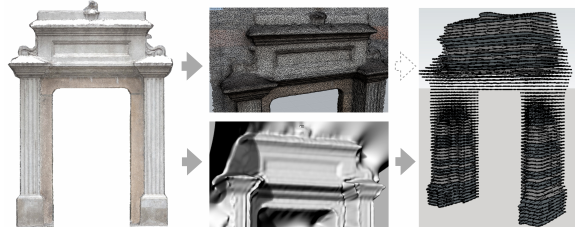
Figure 13. Workflow from point clouds to parametric slices via NURBS instead of mesh